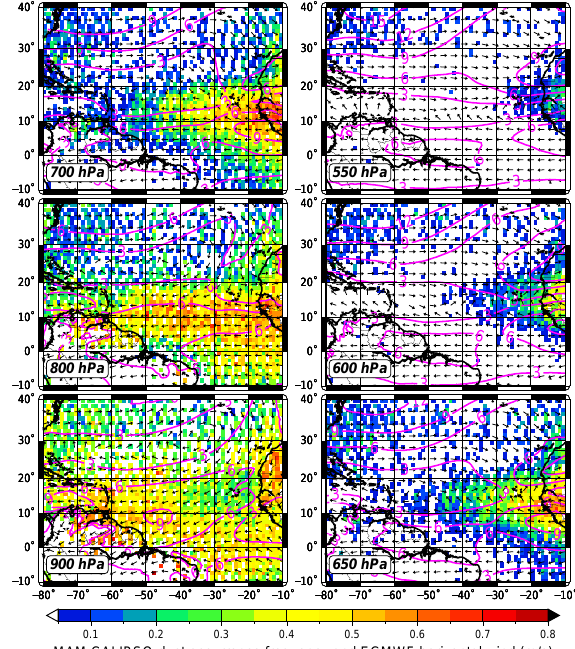
Fig. 11. Same as Fig. 10 but for spring (MAM). Fig. A2. Same as Fig. A1 but for spring